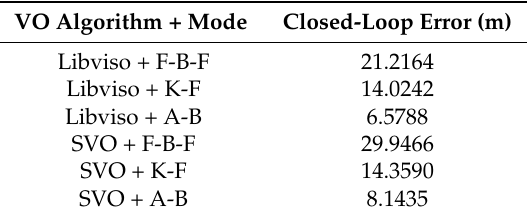
Table 5. Experiment 1: The closed-loop error on